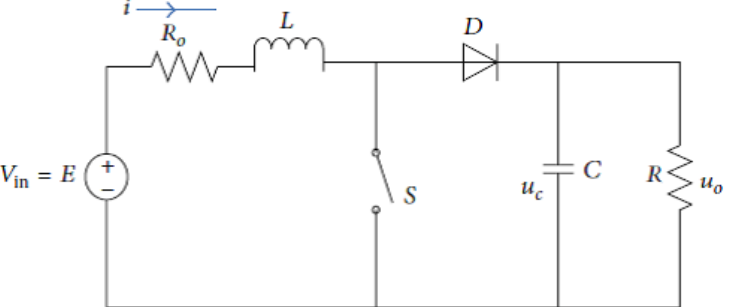
Figure 2. A boost converter with inductor